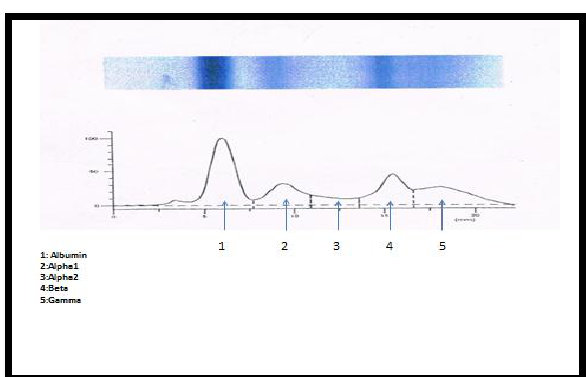
Figure, 1: Serum protein electrophoresis of control rats.